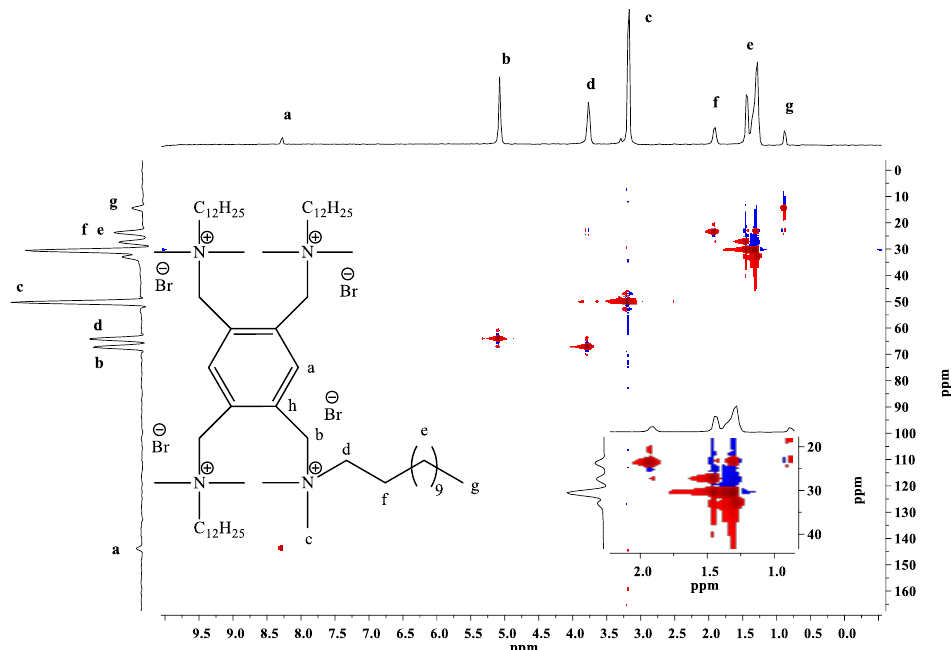
Figure 3. HSQC spectrum (CD 3 OD) of 1,2,4,5-tetrakis[( N -(1-dodecyl)- N , N -dimethylammoniummethyl) benzene tetrabromide ( 21 ).